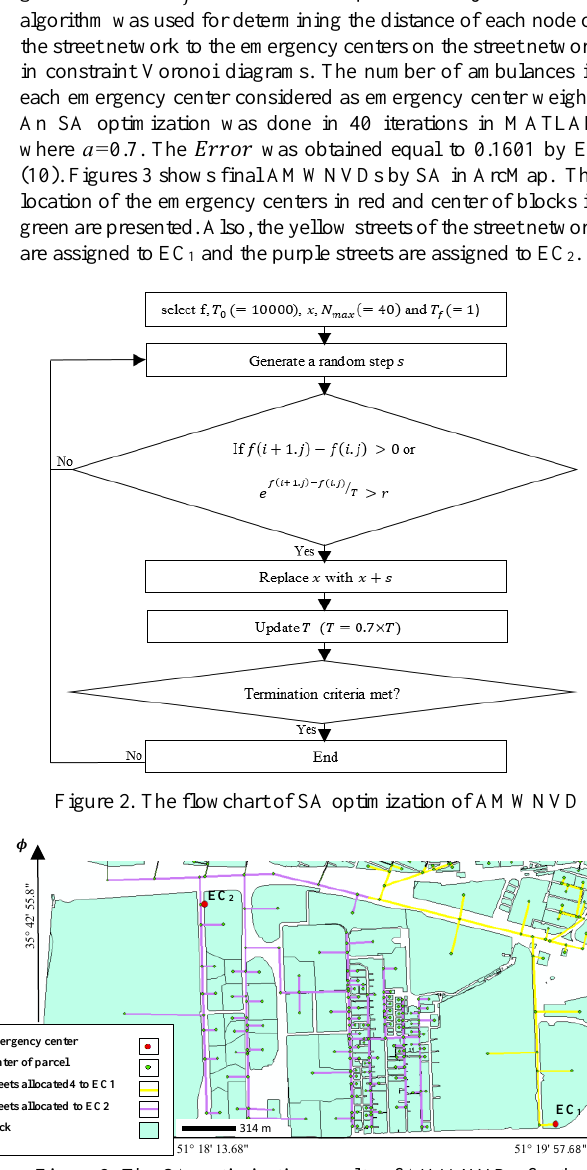
Figure 3. The SA optimization results of AMWNVDs for the emergency centers in ArcMap